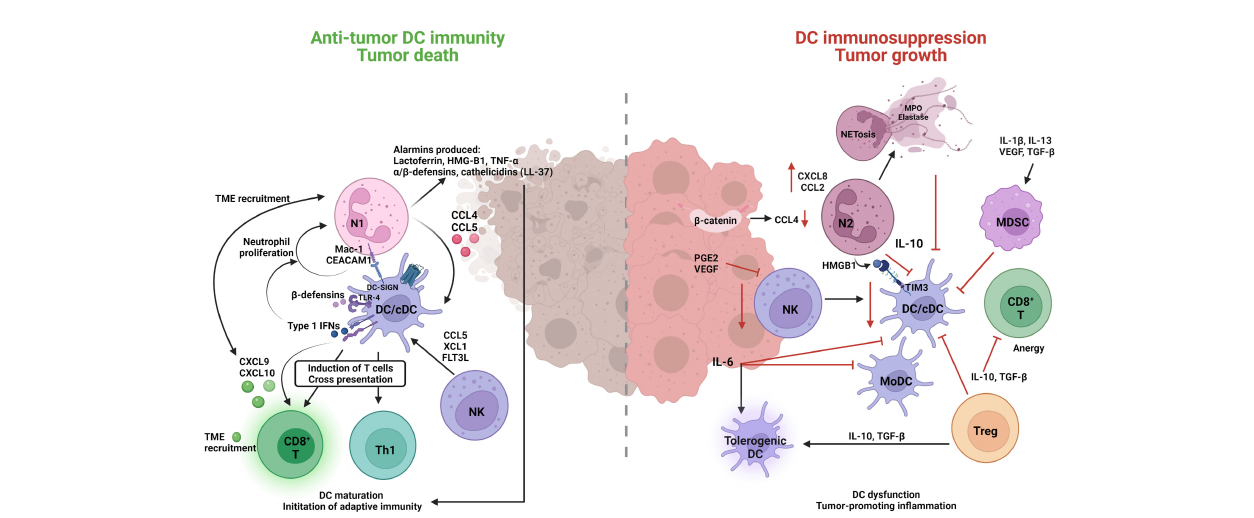
FIGURE 3 | Neutrophil engagement with dendritic cells in the TME can result in immune-suppressive or immune-promotion of cancer pathology. Classical/ conventional DC1 cells (cDC1) are the predominant subtype orchestrating an anti-tumor response through the interplay with N1 TAN, CD8 + cytotoxic T (CD8+ T) and natural killer (NK) cells. N1s produce several alarmins and cytokines that induce DC maturation, TME recruitment, and the initiation of anti-tumor adaptive immunity. DCs in-turn induce N1 proliferation and survival through cytokine/chemokine release, Type l IFNs, b -defensins and direct interaction MAC-CEACAM1/DC-SIGN receptor engagement. N1-induced DCs have a greater propensity to engage with and enhance the functions of anti-tumor CD8 + T cells, Th1, and NK cells to induce cytotoxic killing of tumor cells. On the other hand, N2 TANs and MDSCs have a suppressive role on DC functions and promote tumorigenic tolerant DCs. Reduction in N2 produced CCL4 leads to decreased cDC tumor in fi ltrate, an b increase in N2 CXCL8 and CLL2 contributes to tumor progression and invasion pathways, N2 – DC cell interaction HMGB1-TIM3, and IL-10 production leads to inhibition of cDCs. The inhibition of cDCs further compromises other anti-tumor immune cells (NK, CD8 + T) and allows for suppressive cells (N2, MDSC, Treg, tolerogenic DCs) to promote tumor